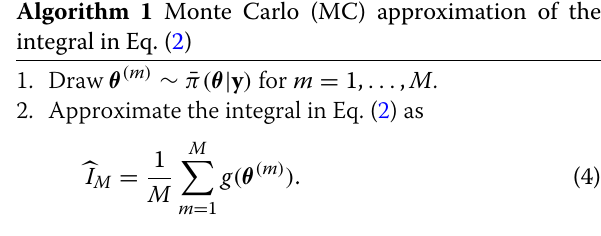
Algorithm 1, or by replicating the physical procedure